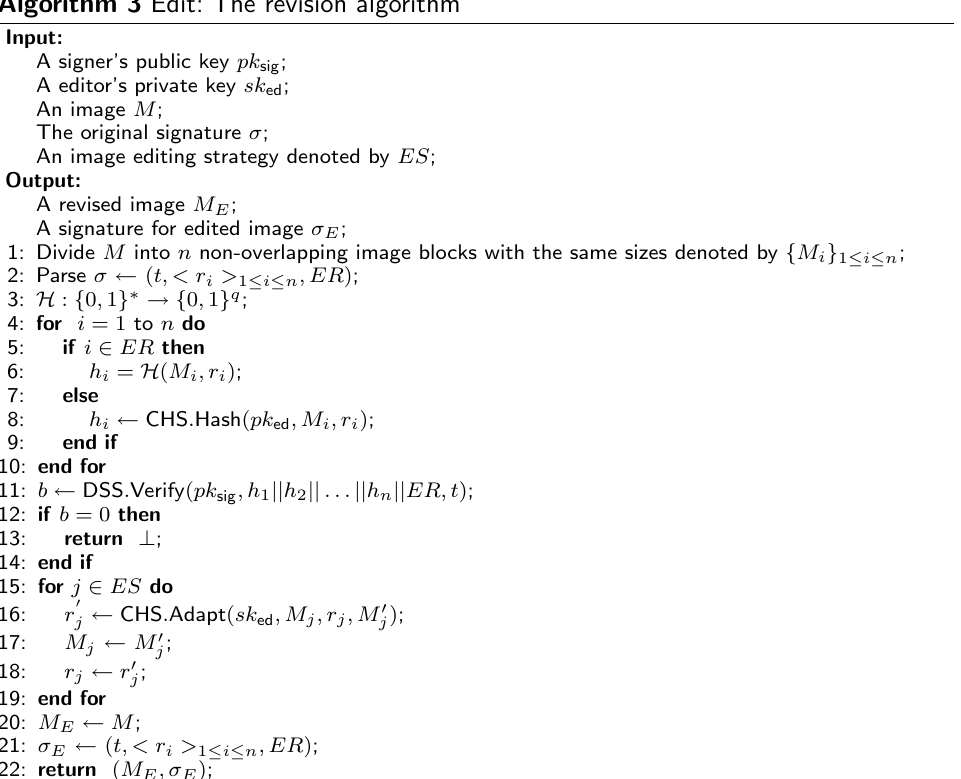
Algorithm 3 Edit: The revision algorithm